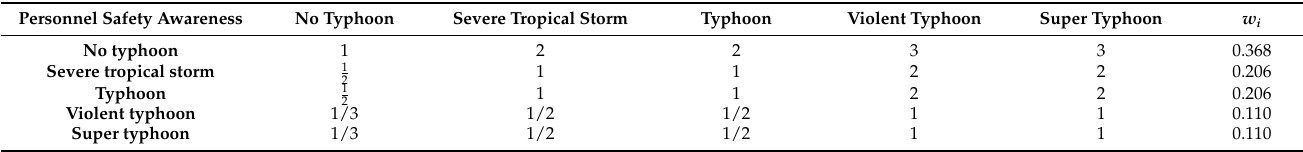
Table 7. The important judgment matrix of personnel safety awareness under different typhoon intensity.